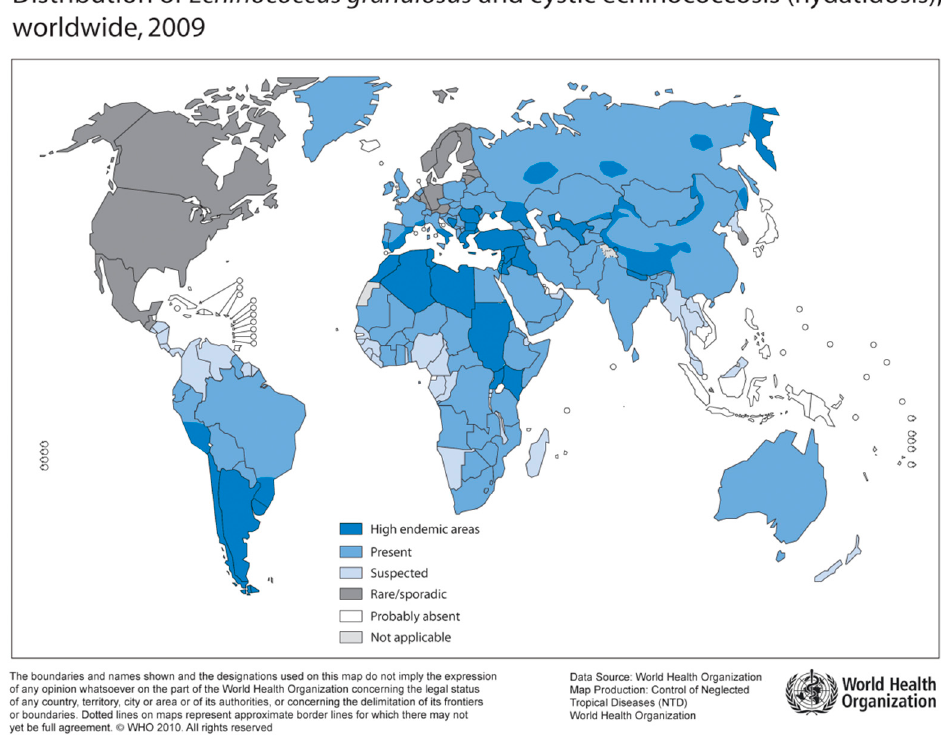
Figure 4. Distribution of E. granulosus and cystic hydatosis, 2009 (Source: WHO, website: http://gamapserver.who.int/mapLibrary/Files/Maps/Global_echinococcosis_2009.png).